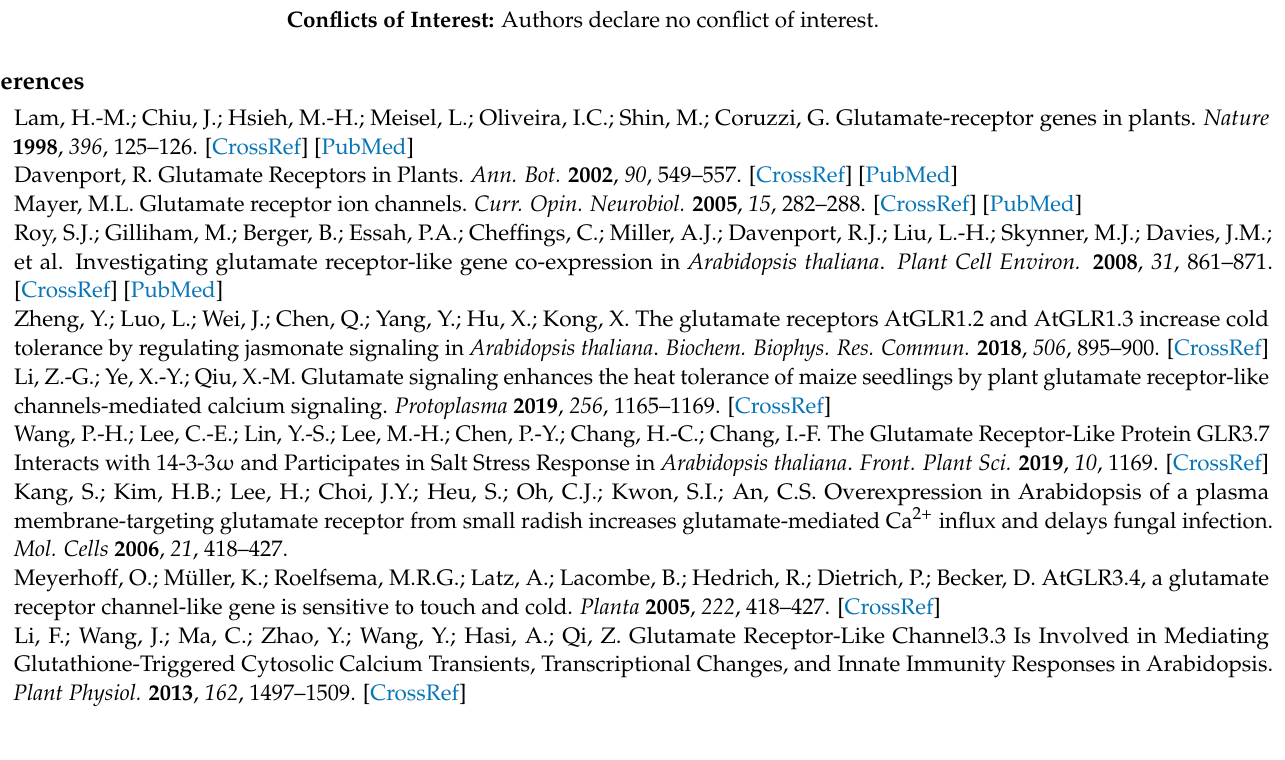
Figure S1. Motif